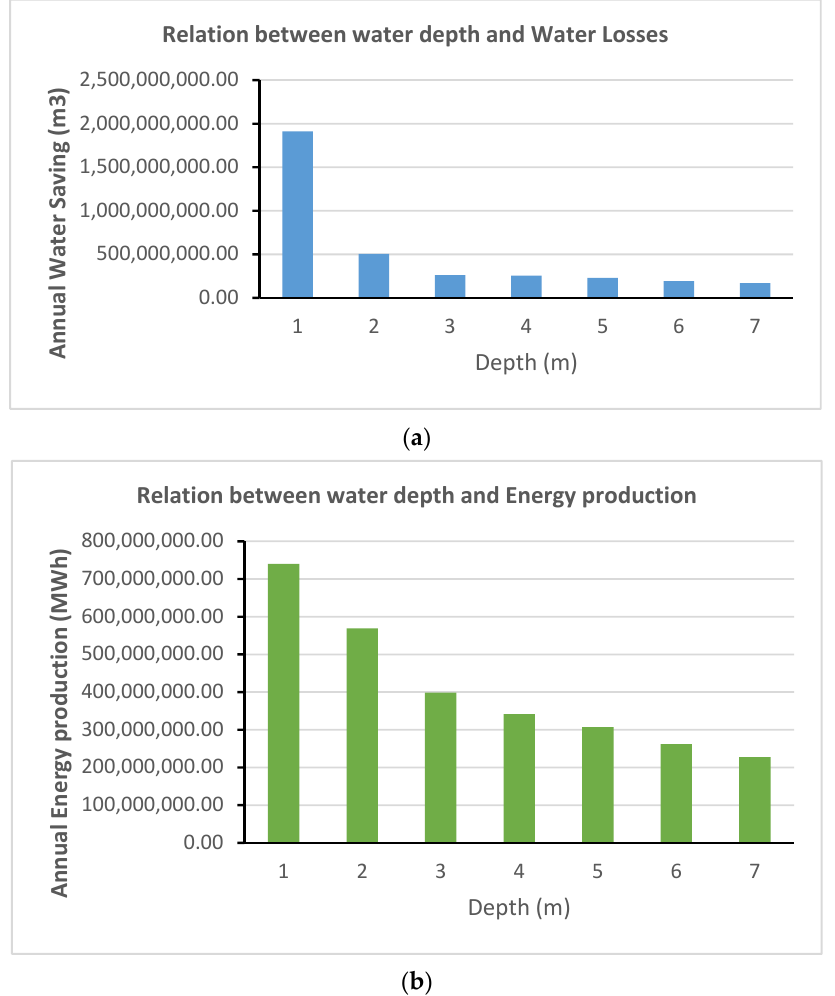
Figure 10. Relations between water depth and water saving and energy production at Lake Nasser: ( a ) water saving, ( b ) energy production.